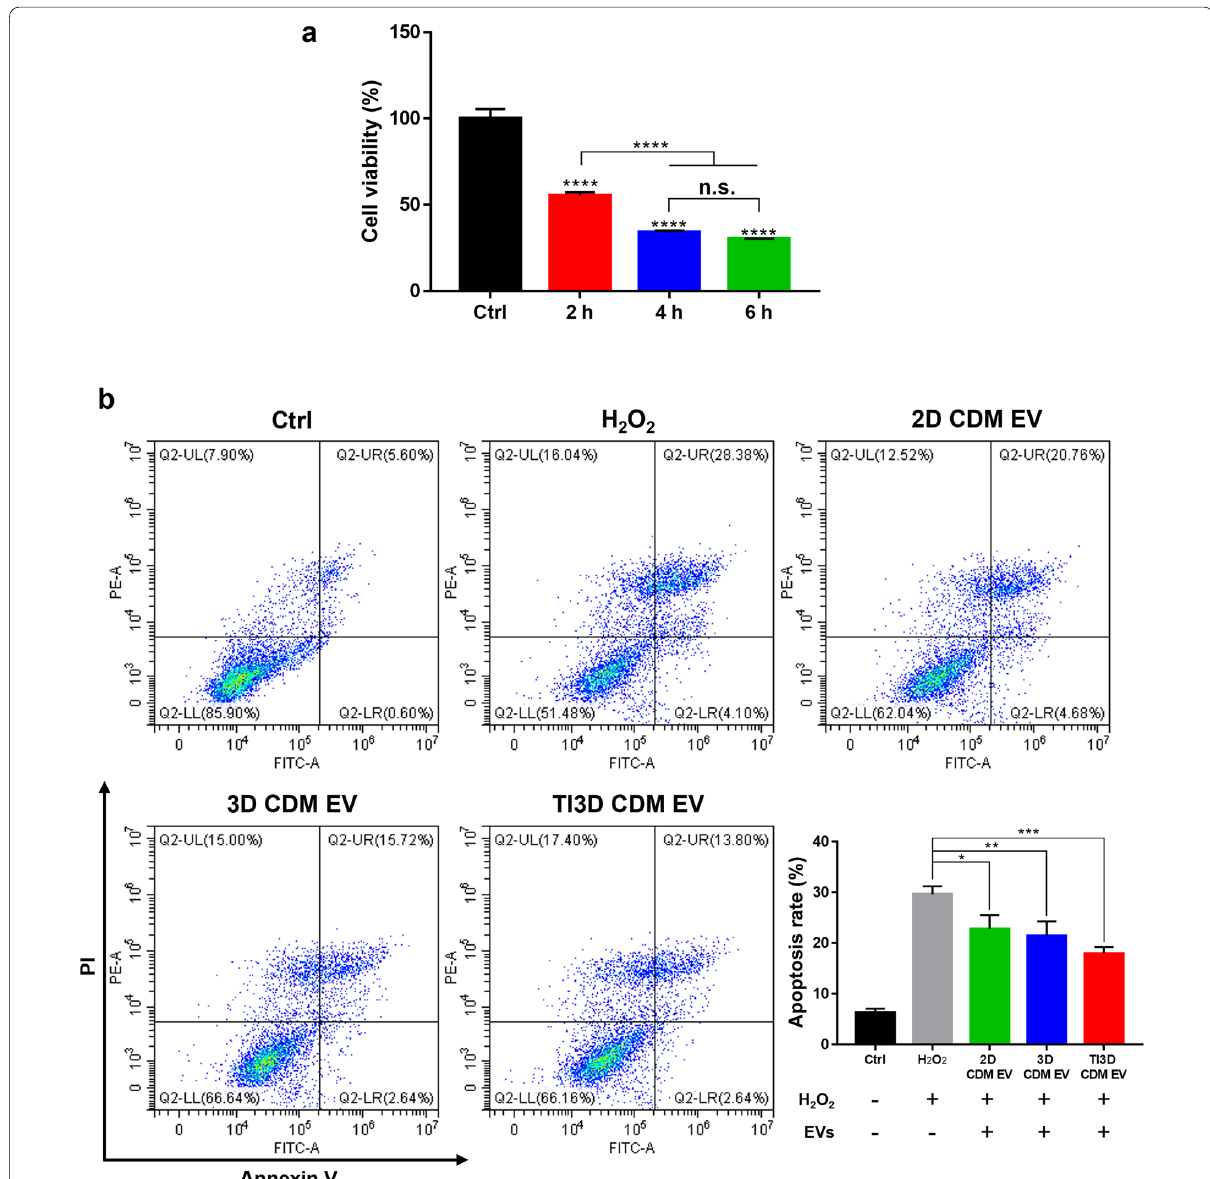
Fig. 7 Anti‑apoptotic effects of EVs. a Screening the optimum concentration of H 2 O 2 for apoptotic cell modeling. b The plots of PI/Annexin V of H 2 O 2 treated HK2 with EVs incubation and calculated the anti‑apoptotic properties of EVs (values are presented as mean statistical significance was obtained with one‑way analysis of ANOVA with Tukey’s multiple comparison post‑test (* p < 0.05; ** p < 0.01; *** p < 0.001; **** p <